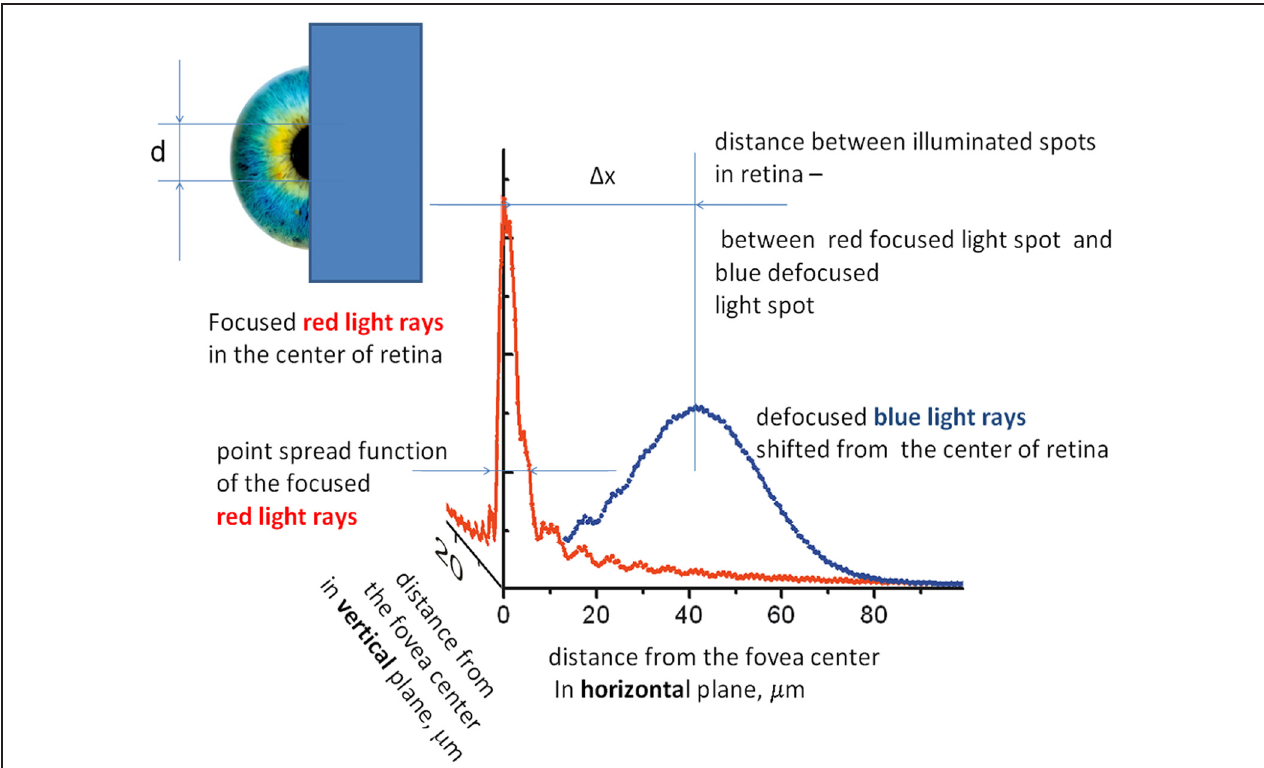
FIGURE 5 | Retinal illumination at the eye’s horizontal and vertical planes from a single-display R + B pixel calculated from the point spread function (PSF) and its defocusing for blue emission. Calculations are performed for eye with half the pupil covered. Inset shows the covering of the eye pupils.